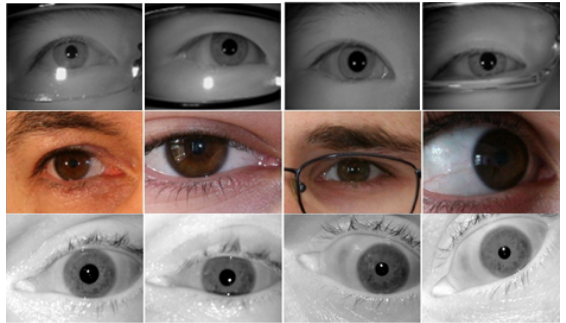
Figure 8. Sample images from the three databases: CASIA-Iris-Thousand ( first row ), UBIRIS.v2 ( second row ) and LG2200 ( third row